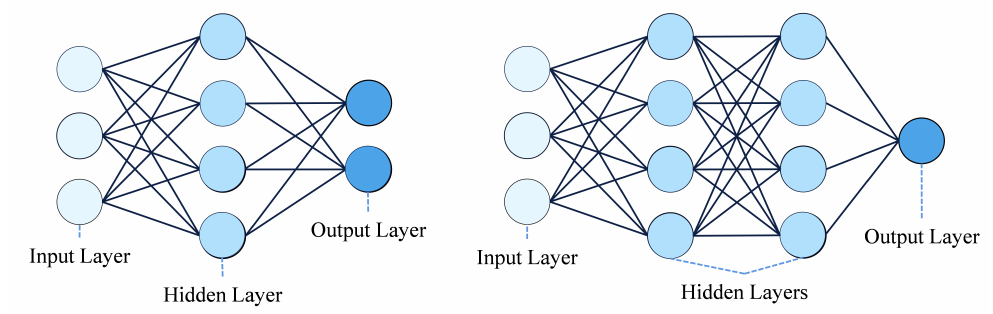
Figure 4. Neural network model with single hidden layer on left and double hidden layer on